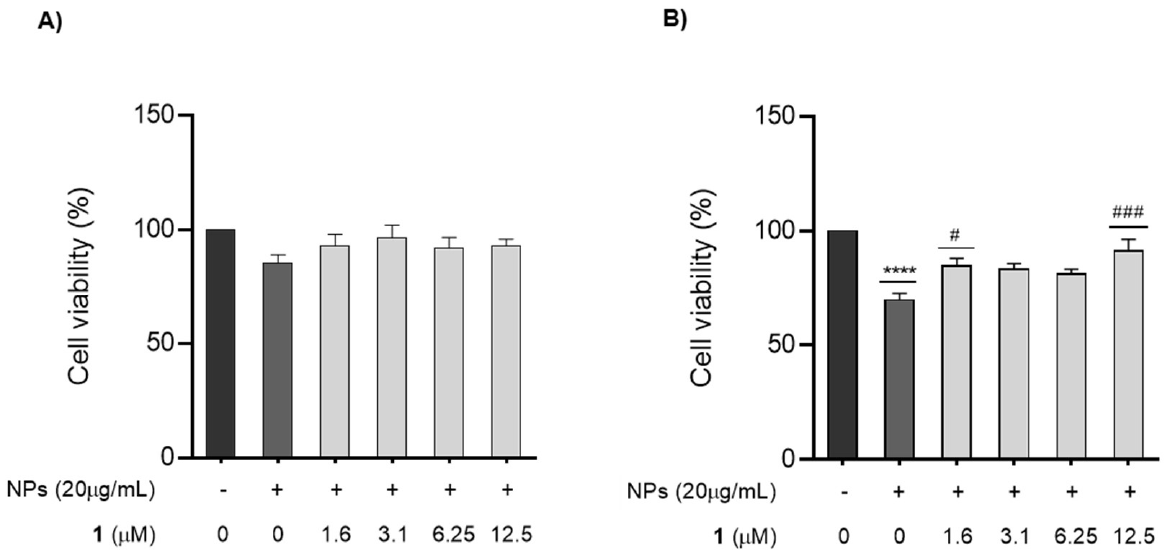
Figure 5. Cell viability assay of cells co-exposed with chalcone 1 and ZnO NPs. Changes in the viability of the GC-1 cells treated with 20 µ g/mL of ZnO NPs in the absence and presence of different concentrations of chalcone 1 (0–12.5 µ M) after ( A ) 6 and ( B ) 12 h of exposure. The percentage of viable cells for each condition was plotted as mean ± SEM of five independent experiments, performed in duplicate. Values are expressed as arbitrary units, and the cell viability of the control condition is given a value of 100. **** p < 0.0001 compared to the control group, # p < 0.05 and ### p < 0.001 compared to the group treated with ZnO NPs, using one-way ANOVA. NPs: nanoparticles.